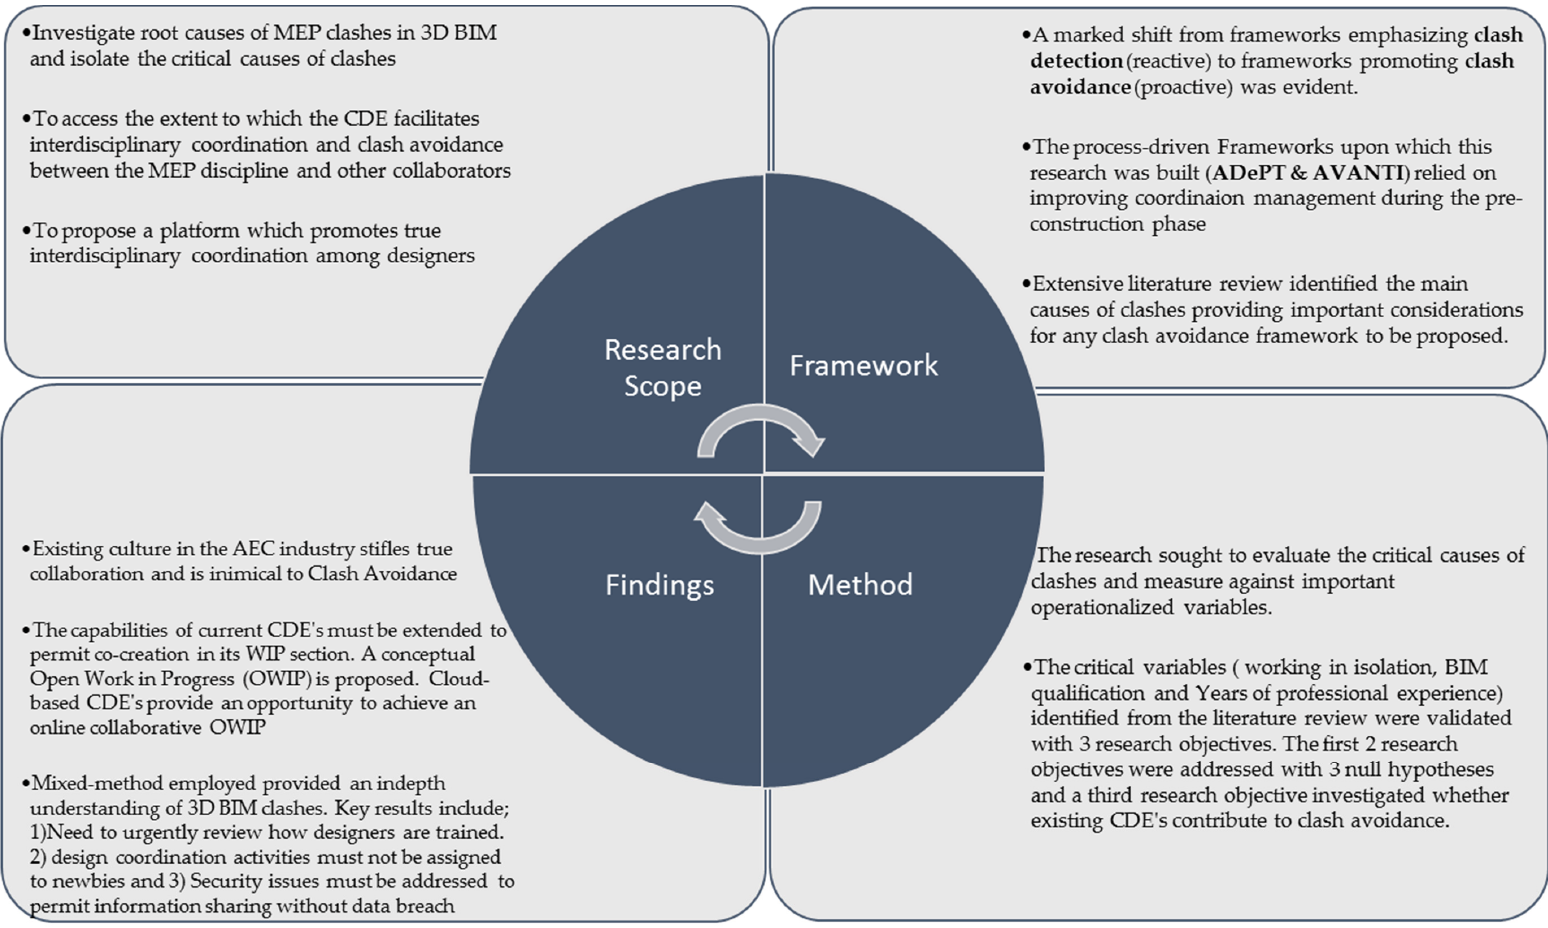
Figure 5. Relationships between scope, framework, method and findings.